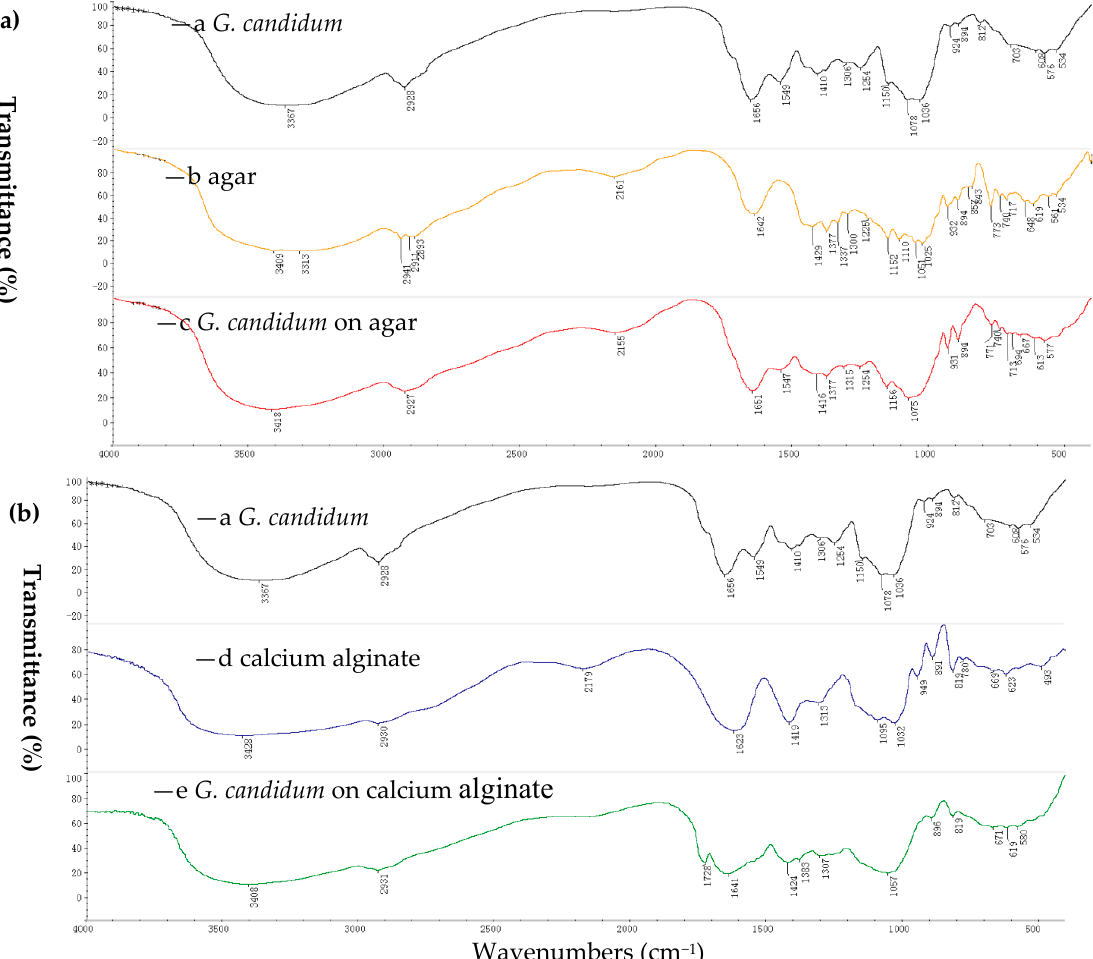
Figure 1. Fourier transform infrared (FTIR) for immobilization of G. candidum AS 2.361 on agar ( a ), on calcium alginate ( b ): —a G. candidum AS 2.361; —b agar; —c G. candidum AS 2.361 on agar; —d calcium alginate; —e G. candidum AS 2.361 on calcium alginate.